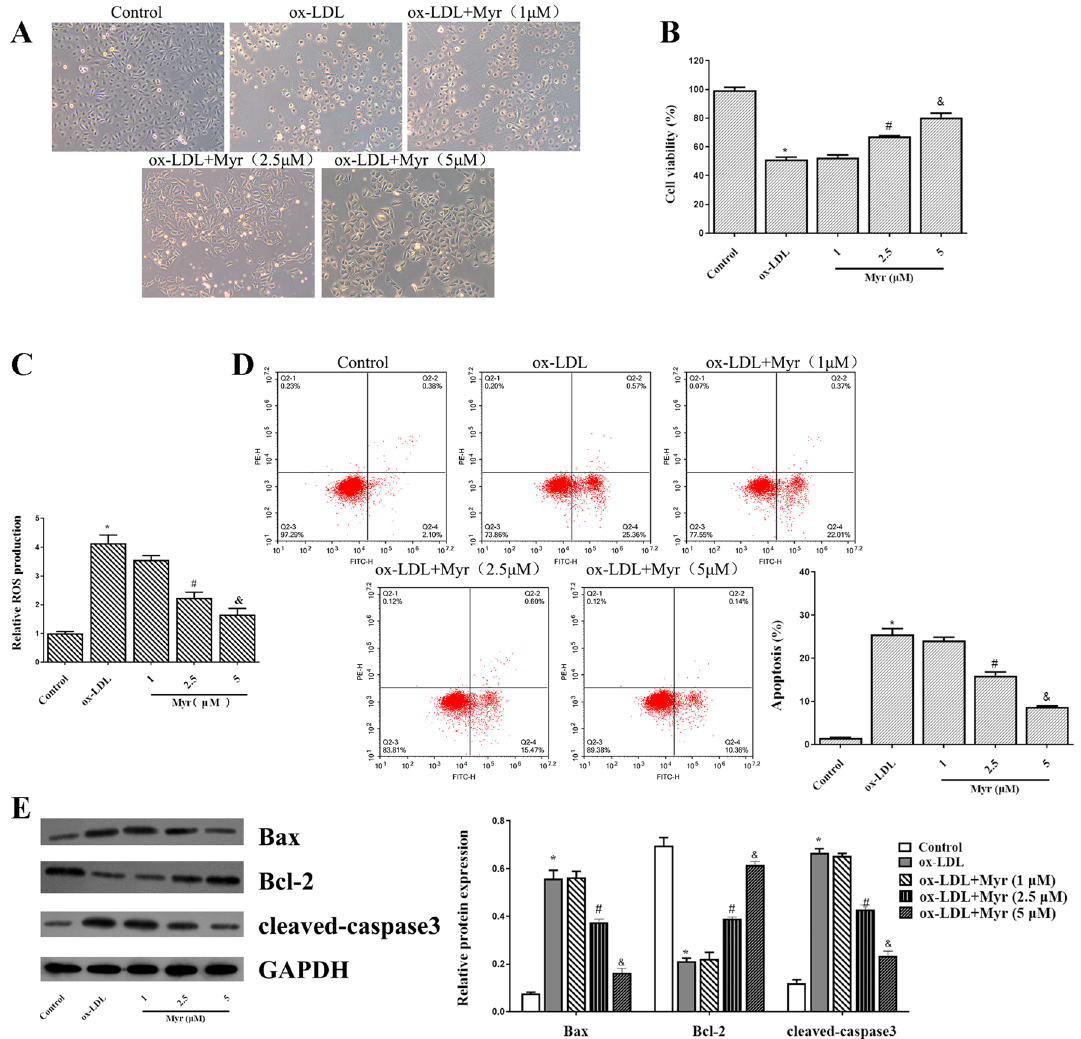
Figure 1. Myr attenuates ox-LDL-induced apoptosis in HUVECs. ( A ) Observed under a microscope and photographed for different groups. ( B ) CCK8 assay of different Myr concentrations on ox-LDL-induced HUVECs cell viability. ( C ) The production of ROS was detected by ROS Assay Kit. ( D ) Representative FACS plots of Annexin V fluorescein isothiocyanate (FITC)/propidium iodide (PI) stained endothelial cells treated with ox-LDL or cotreated with ox-LDL and Myr at different concentrations for 24 h. ( E ) The expression of apoptosis-associated proteins was determined by western blotting. * P < 0.05 compared with control; # P < 0.05 compared with ox-LDL; & P < 0.05 compared with 2.5